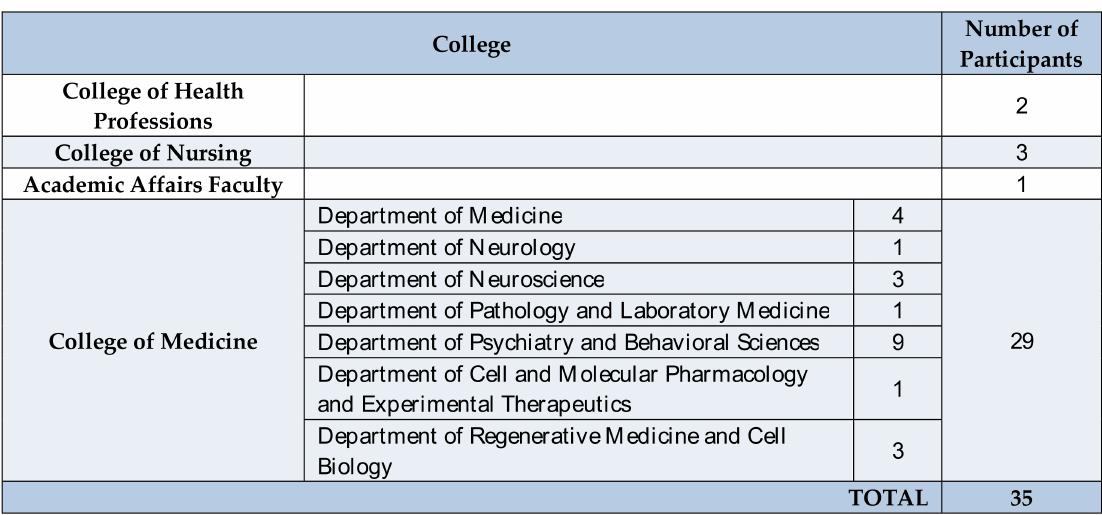
Figure 1. Demographics of Colleges and Departments